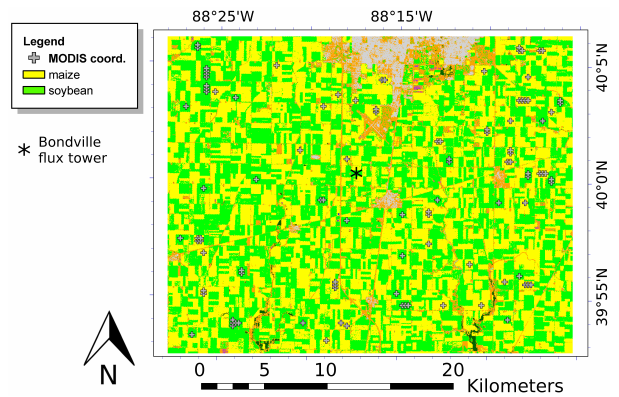
Fig. 2. The crop data layer of the study area. Selected MODIS composite coordinates are indicated (grey crosses). The study area is dominated by maize (yellow) and soybean (green) cultivations.